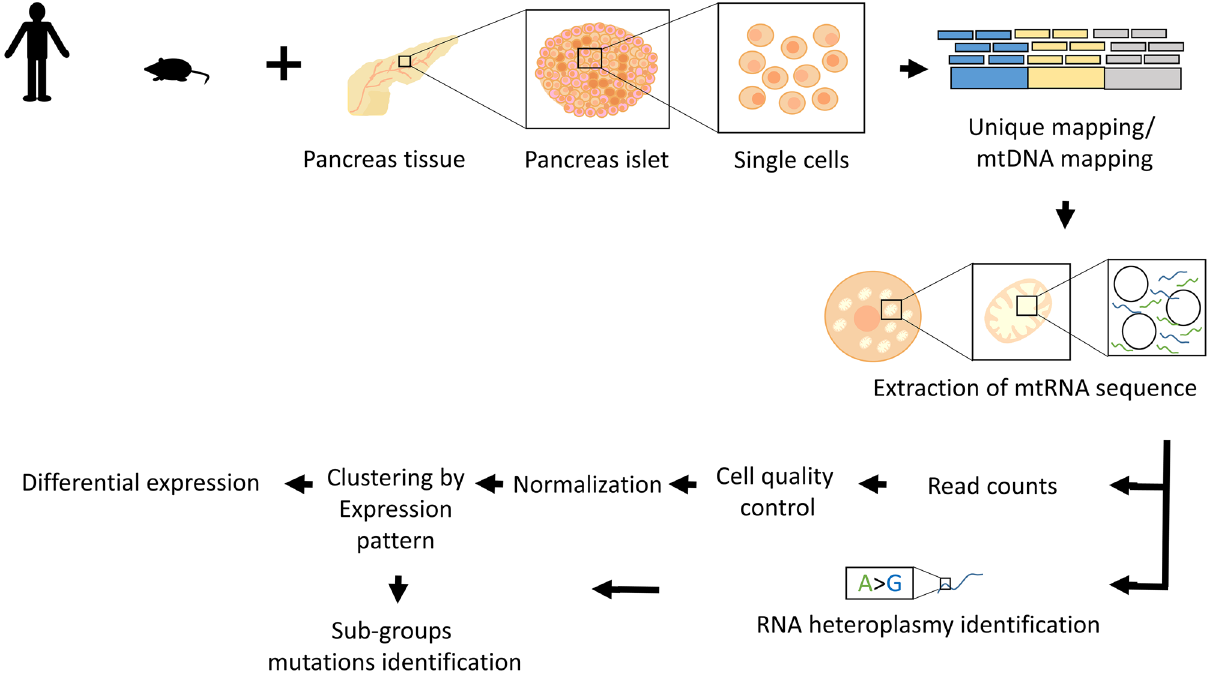
Figure 1. Workflow of scRNA-seq analysis. Hypothesis free scRNA-seq clustering according to mtDNA gene expression. Fastq-files were mapped against the entire genome (GRCh38 for human cells and GRCm38 for mouse cells). After mapping, we calculated read counts, followed by data quality assessment, clustering and differential expression analyses. The RNA mutational heterogeneity data was used to identify mutations that characterize each of the identified cell groups per individual, in the Fluidigm C1 platform (see